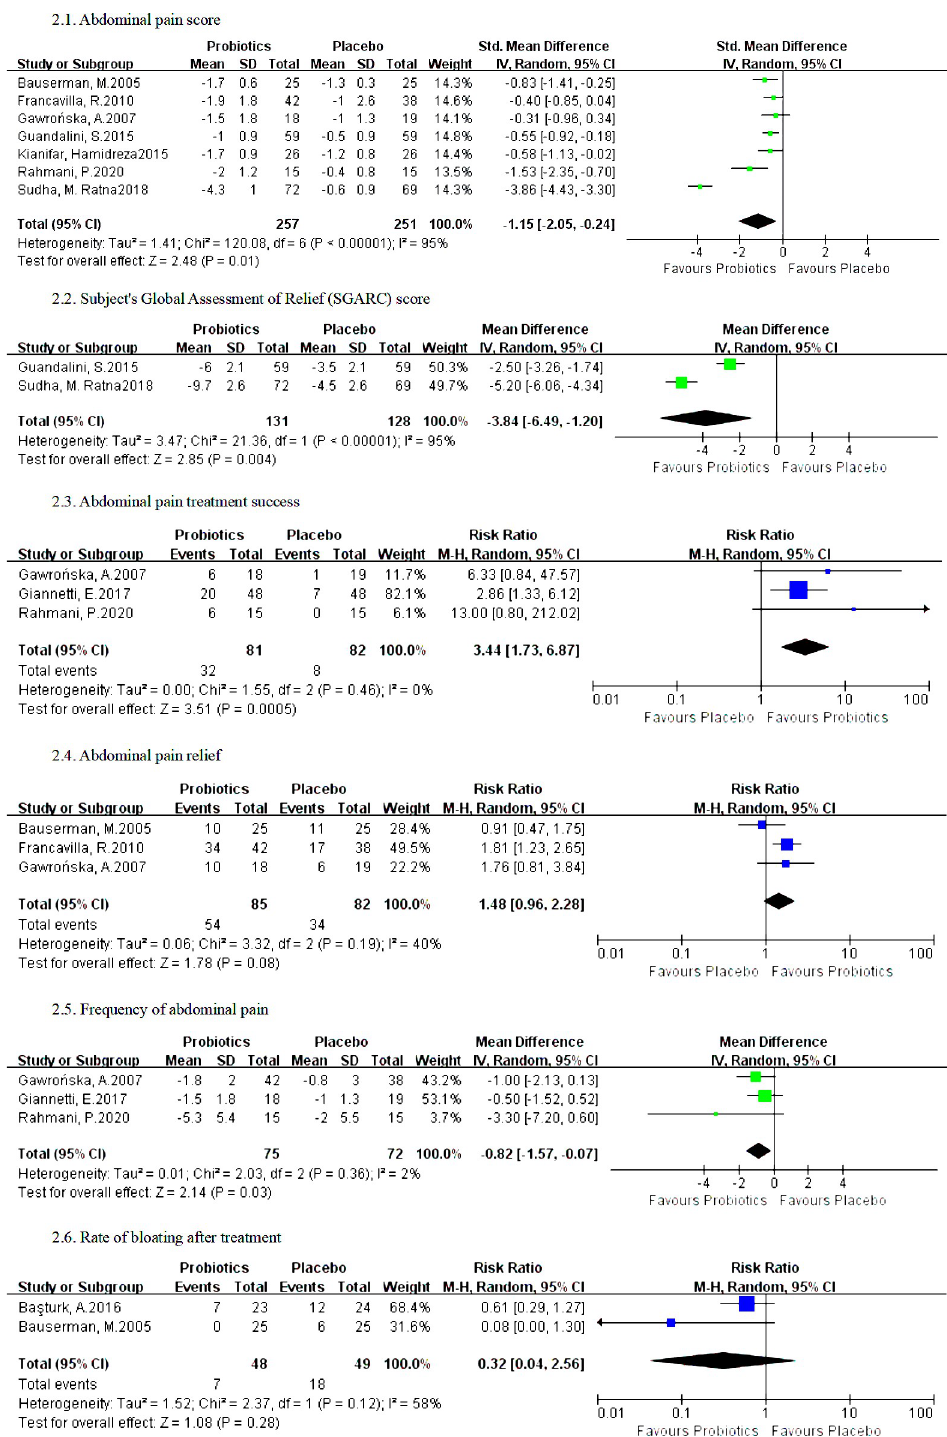
Fig 3. Forest plot comparing the probiotic and placebo